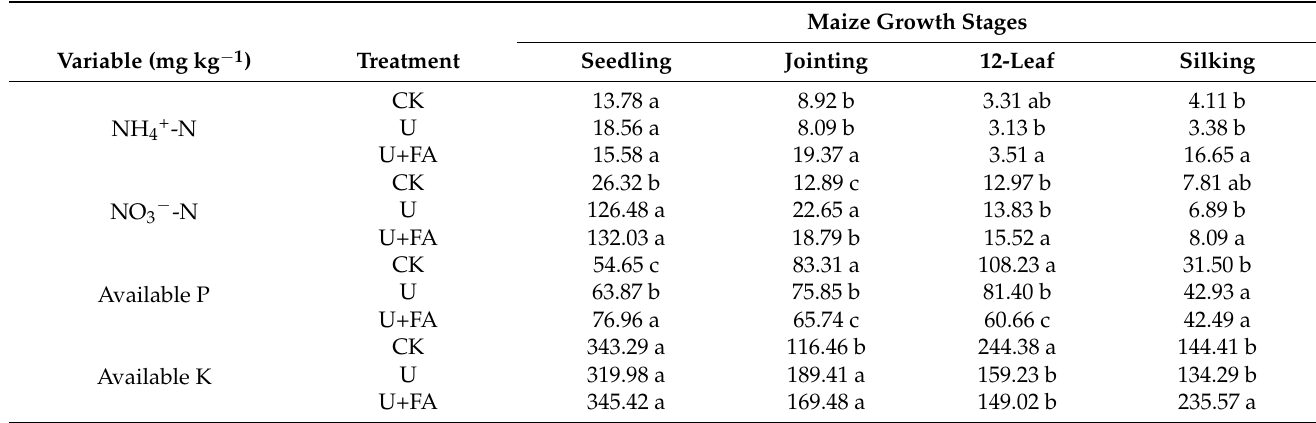
Table 3. Effects of different fertilization treatments on soil nutrients in 2017. one-way ANOVAs followed by SNK’s test at p < 0.05.